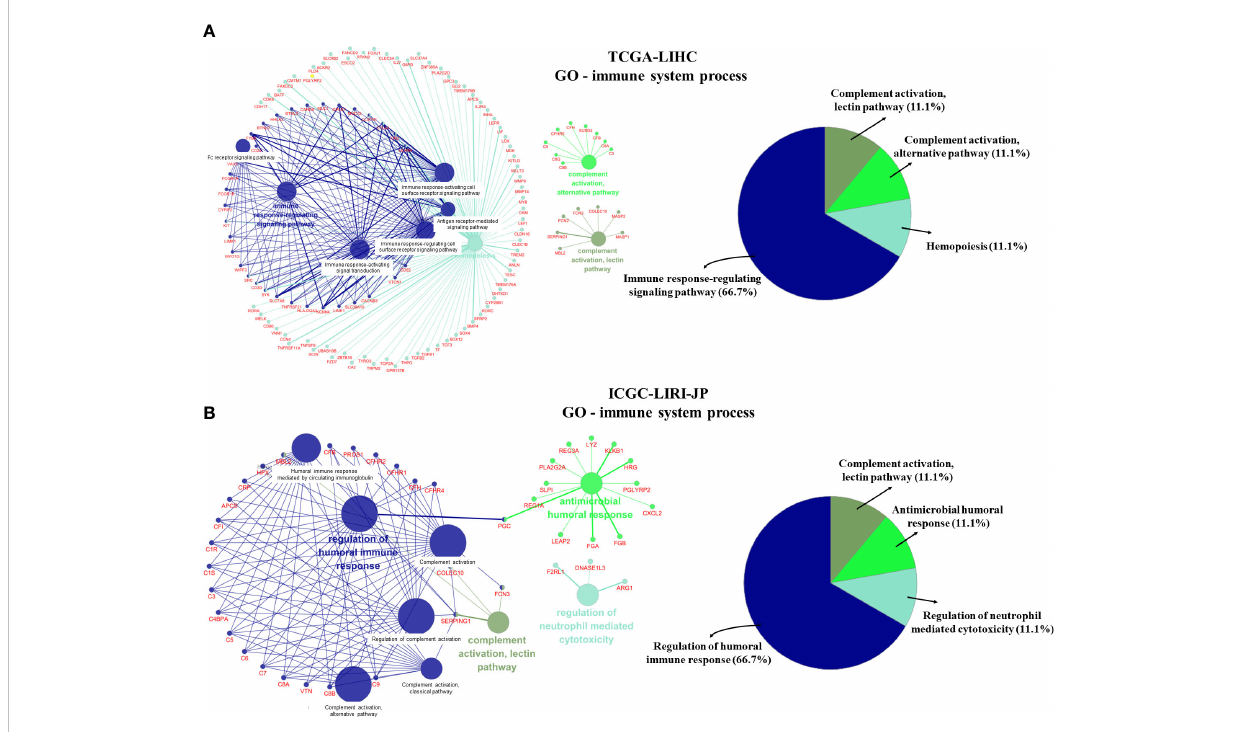
FIGURE 4 GO-immune system process pathway enrichment using differentially expressed genes (DEGs). (A) GO-immune system process pathway enrichment in the TCGA-LIHC dataset. (B) GO-immune system process pathway enrichment in the ICGC-LIRI-JP